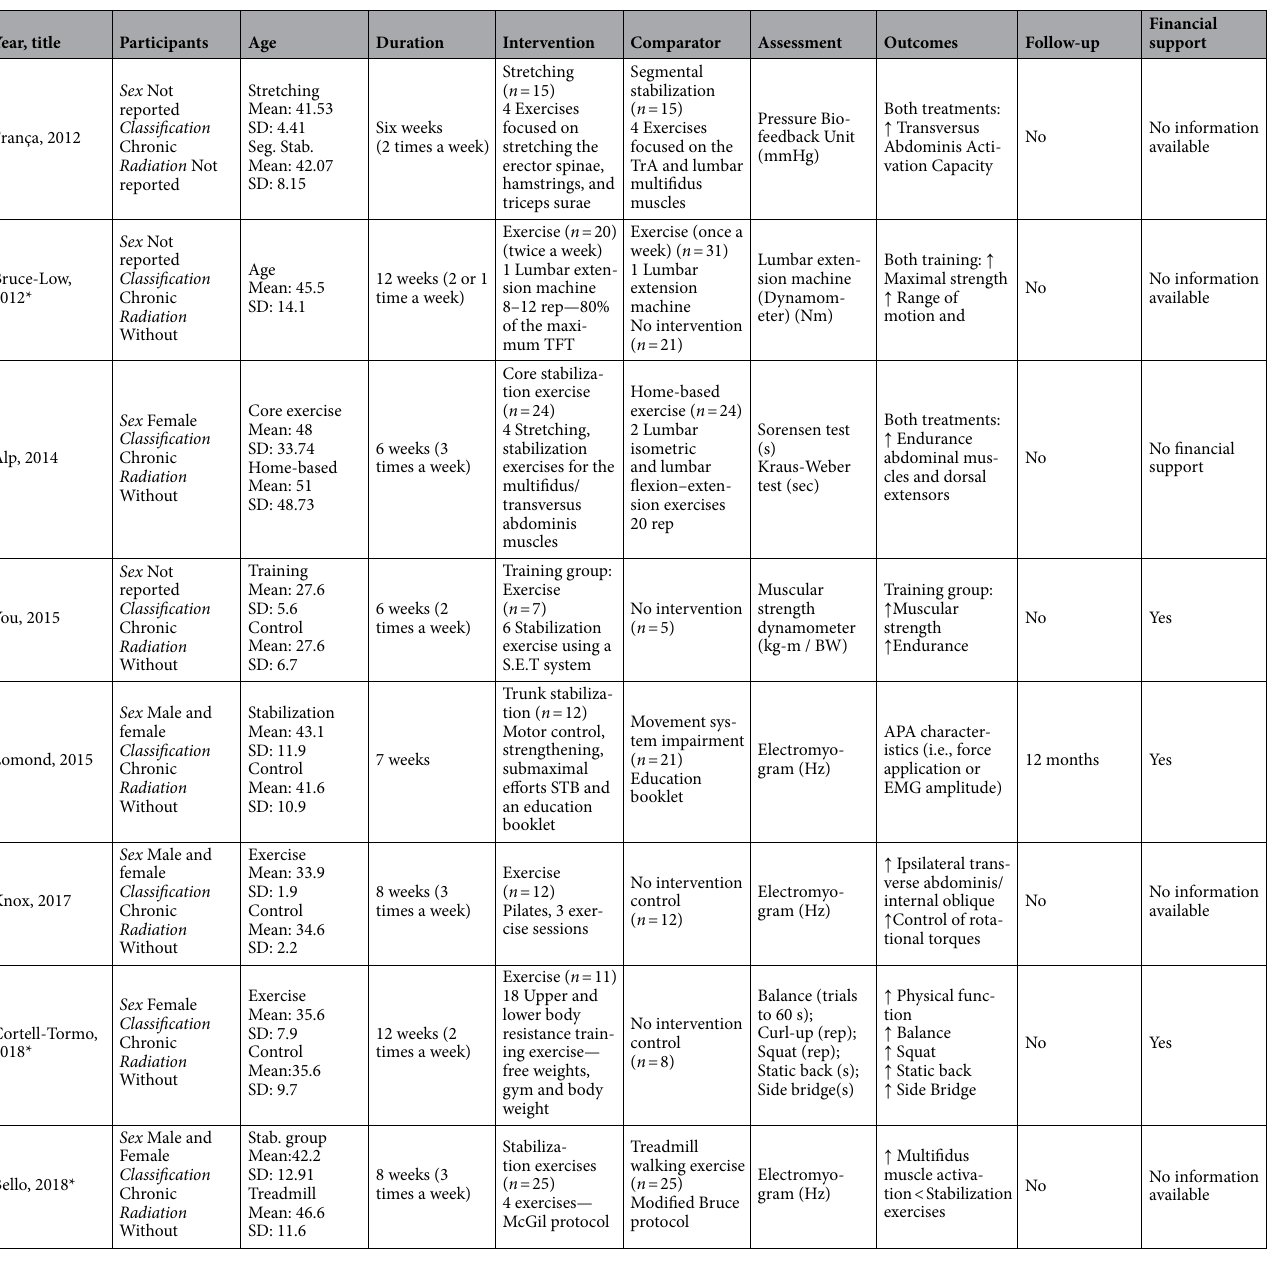
Table 1. Characteristics of included studies ( n = 17). HIT high-intensity training, LIT low-intensity training, TrA transversus abdominis. *Studies included in the meta-analysis. ↔ No significant difference, ↑ Significant Increase, ↓ Significant Decrease, < Significantly